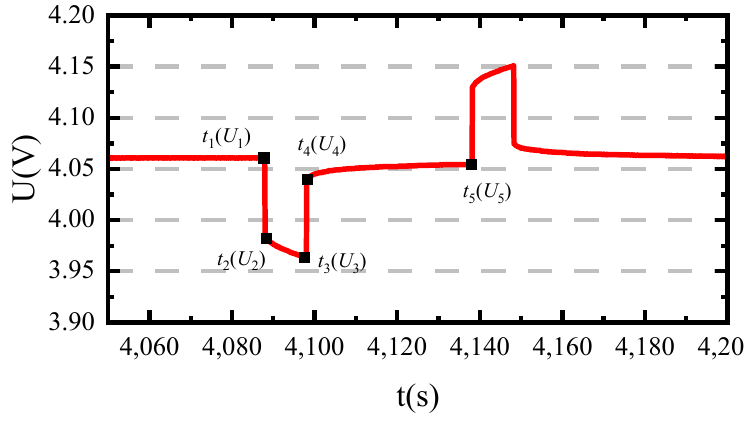
Figure 3. Voltage curve at SOC =